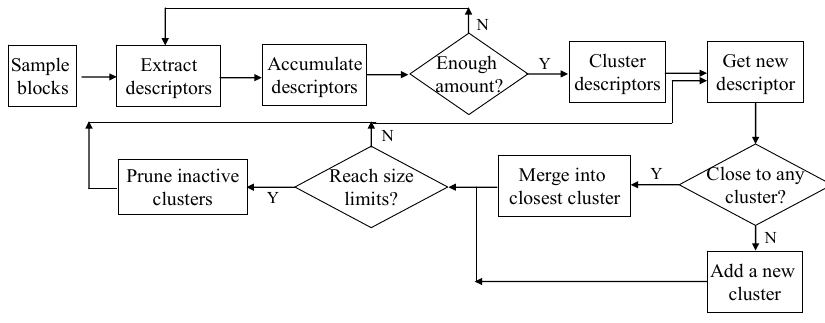
Figure 6. Adaptive appearance prototype building.